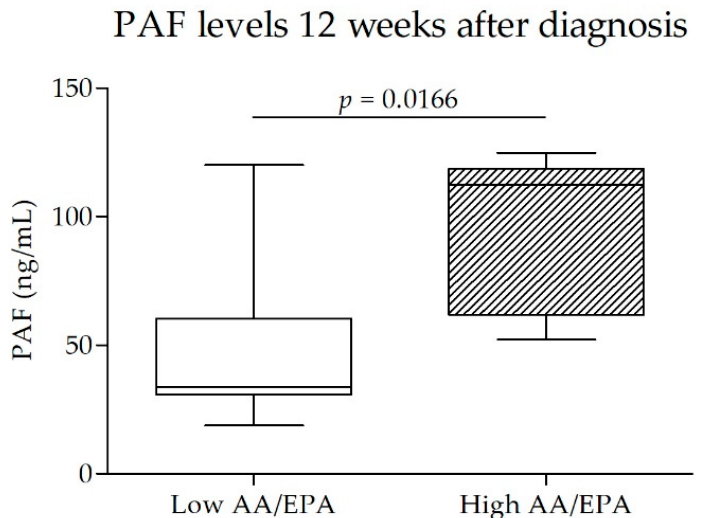
Figure 4. Comparison of PAF levels at the end of the study (after 12 weeks from randomization; T12) between subjects within the lower quartile of AA/EPA ratio in red blood cells at enrollment ( n = 13; AA/EPA < 28.7; Low AA/EPA) and subjects within the higher AA/EPA ratio quartile ( n = 13; AA/EPA> 55.2; High AA/EPA). AA/EPA—arachidonic acid/eicosapentaenoic acid ratio.